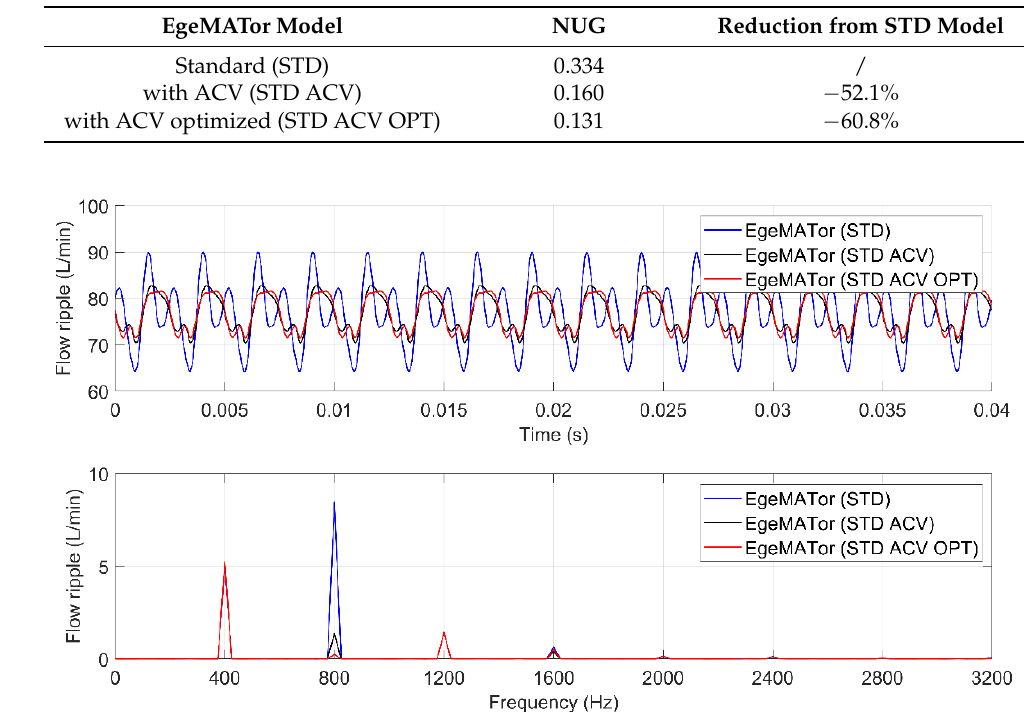
Figure 19. Flow ripple comparison at 1500 rpm and 230 bar in time and frequency domains.